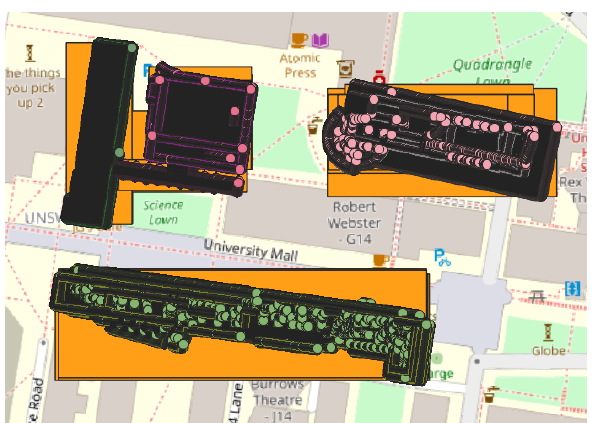
Figure 8. Visualisation of Eval-III via QGIS. Object painted in orange belong to the bounding box. The bottom green is “Built Environment”.